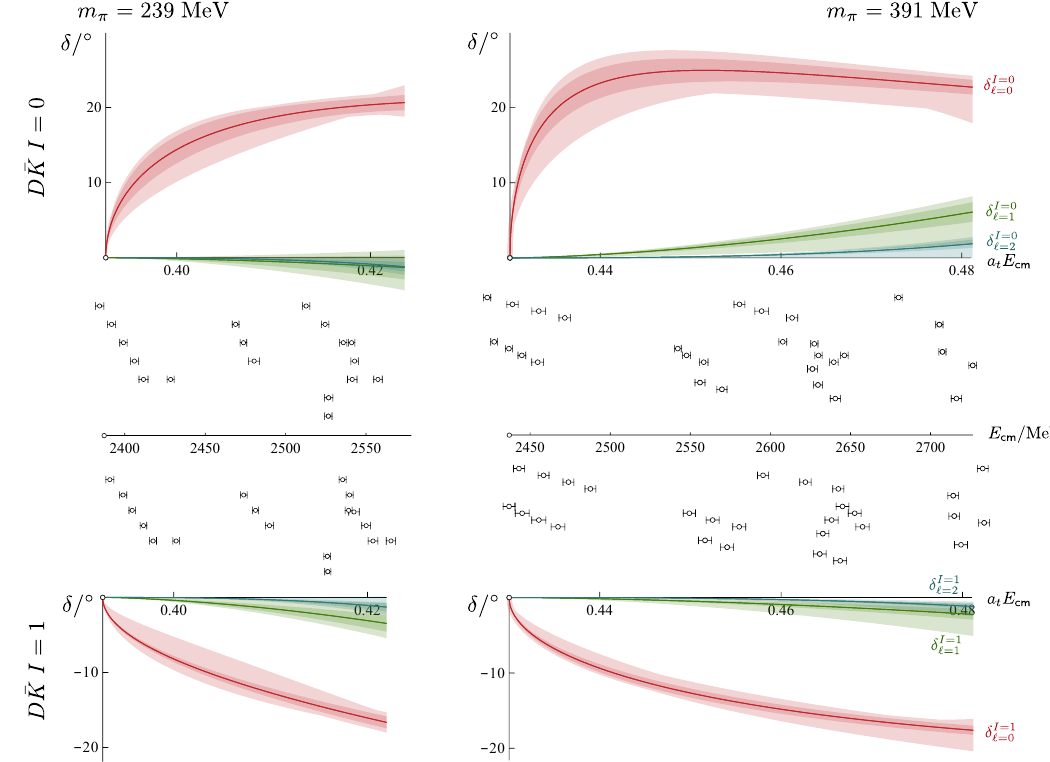
Figure 15 . As figure 14, but the lighter outer bands now also include an envelope over the acceptable parameterisations in table 5 including their statistical uncertainties. The black points in the middle show the computed finite-volume energy levels from section 4 used to constrain the amplitudes.